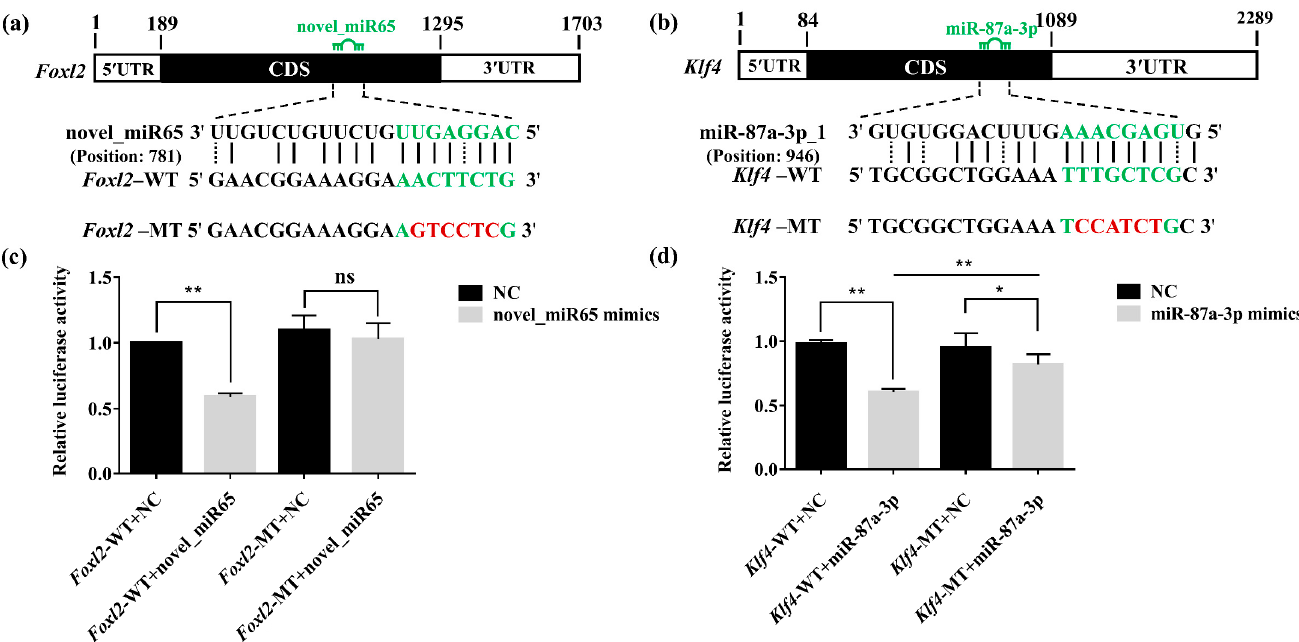
Figure 7. Dual-Luciferase report assay to validate the interaction between miRNAs and their targeting genes ( a ) The predicted binding sites of cfa-novel_miR65 on the CDS region of Foxl2 ; the introduced mutation sequences were in red. ( b ) The predicted binding sites of cfa-miR-87a-3p_1 on the CDS region of Klf4 ; the mutation sequences were in red. ( c ) The relative luciferase activity in cfa-novel_miR65 + Foxl2 assay. ( d ) The relative luciferase activity in the cfa-miR-87a-3p_1 + Klf4 assay. NC, negative control. The luciferase activity of pmirGLO-WT + NC was set to “1.00” to calibrate the relative expression. Asterisks (**), p < 0.01, asterisks (*), p < 0.05, ns, nonsignificant.